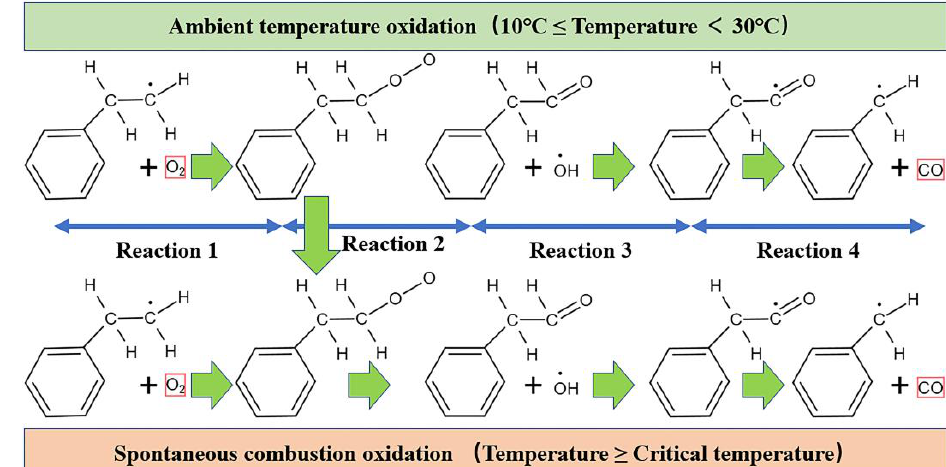
Figure 11. CO production mechanism.